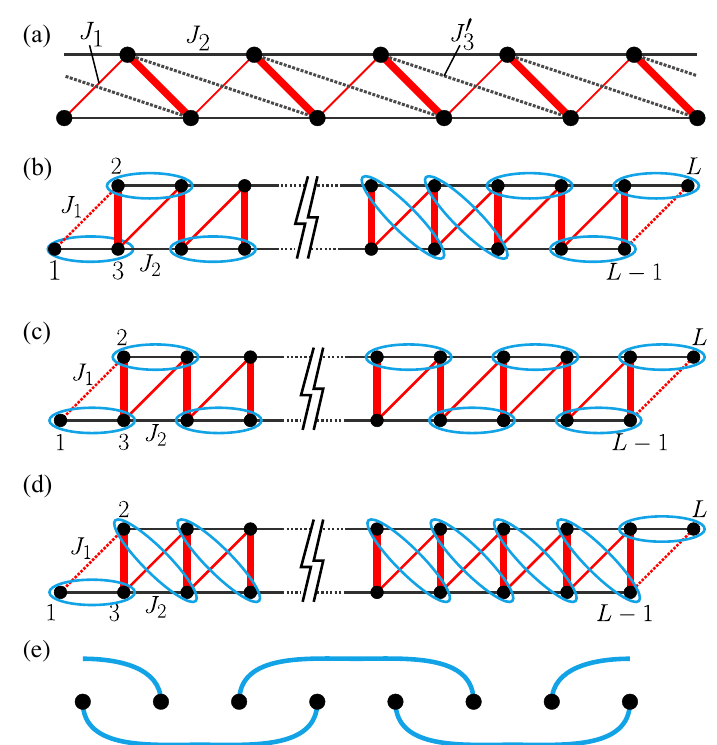
= 0) as a zigzag ladder. - J chain (at J (cid:48) 1 2 3 3 -VBS state”) of the FM D 3